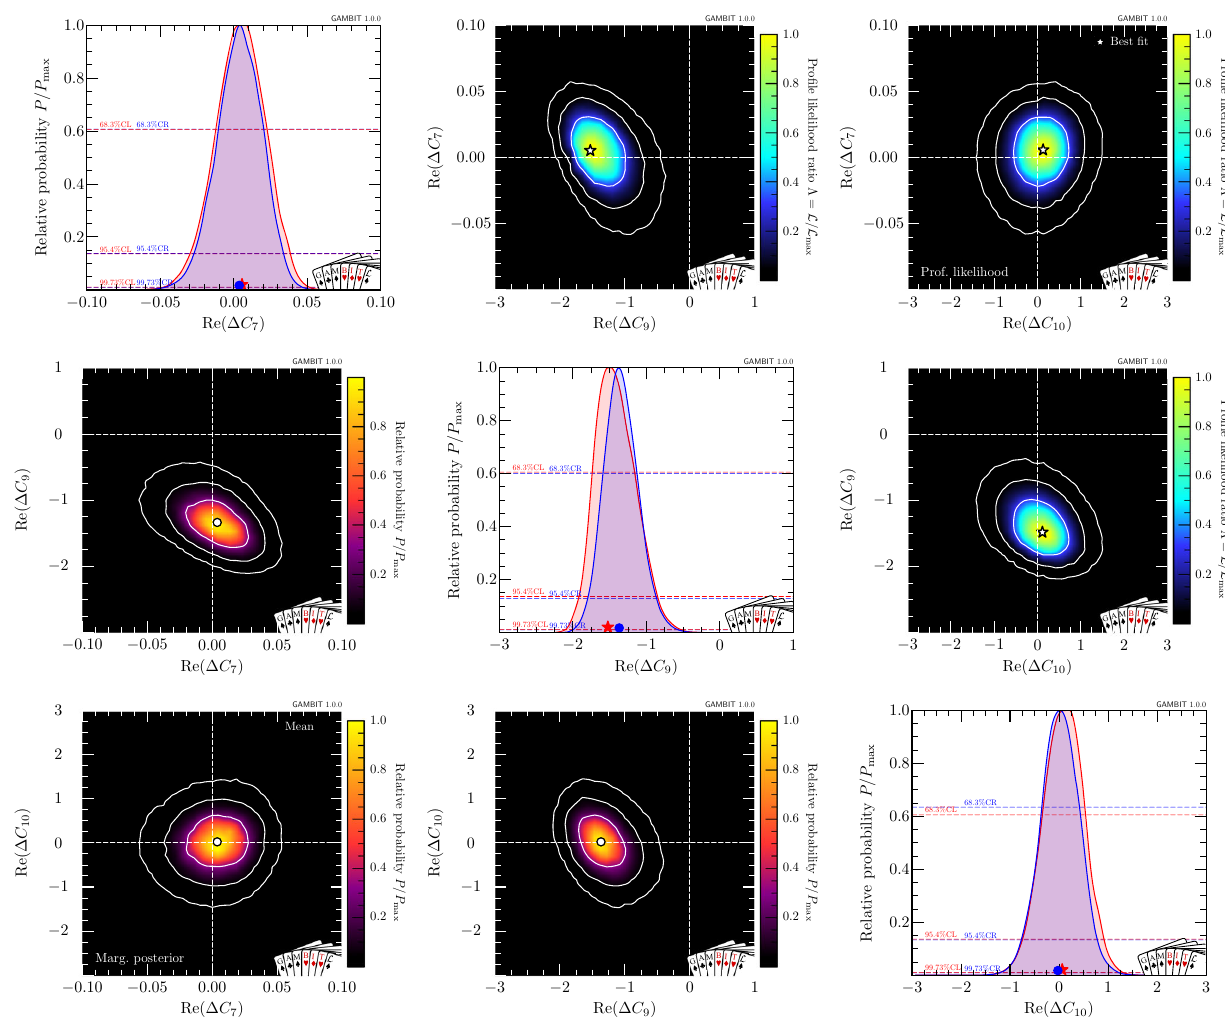
Fig. 2 Profile likelihoods (upper right panels) and posterior probabil- ities (bottom left panels) from a scan over the real parts of the Wilson coefficients C 7 , C 9 and C 10 , expressed in terms of the offsets Δ C i from the SM values. The central diagonal shows both 1D posterior probabili-